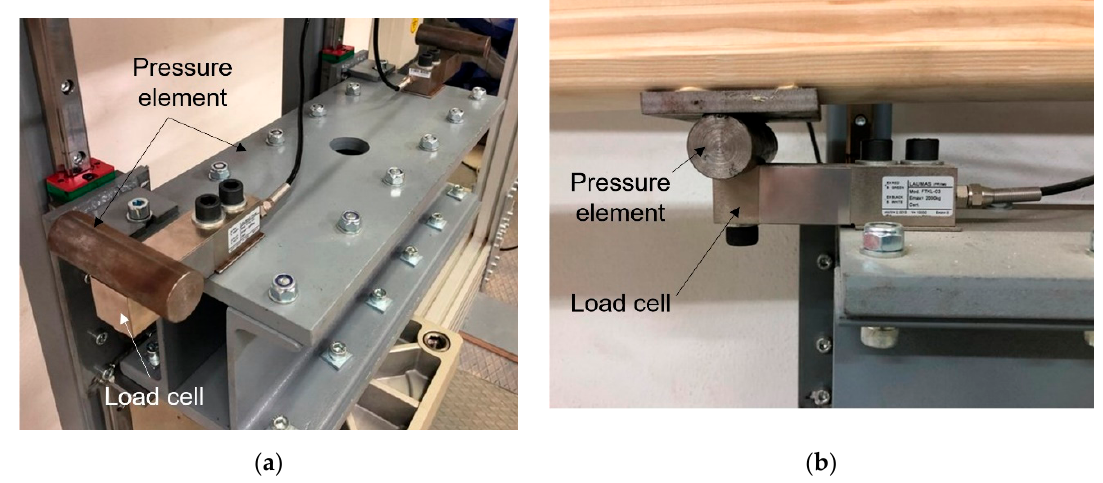
Figure 14. ( a ) Pressure element with load cells; ( b ) the side profile of the load cell during fatigue of a wood specimen.